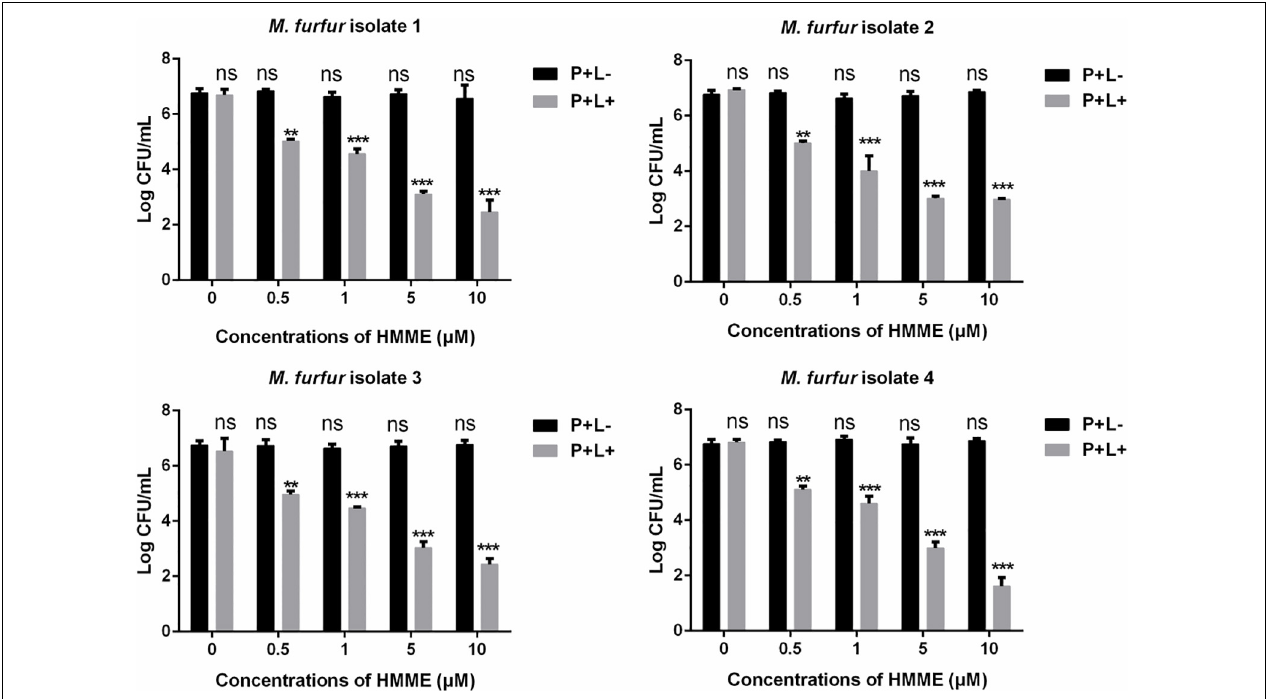
FIGURE 2 | Survival of M. furfur clinical isolates after aPDT mediated by HMME. (P+L–) represents the M. furfur cells treated with different concentrations of HMME in the dark; (P+L+) represents the M. furfur cells treated with different concentrations of HMME and irradiated with 96 J cm − 2 of light. Each value refers to mean ± standard deviation (SD; n = 3; ns: no significance, ** P < 0.01, *** P <